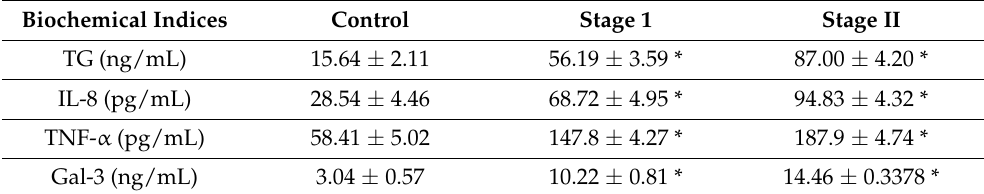
Table 4. Mean ± SD of serum TG, IL-8, TNF-α and Gal-3 levels by ELISA technique. Biochemical Indices